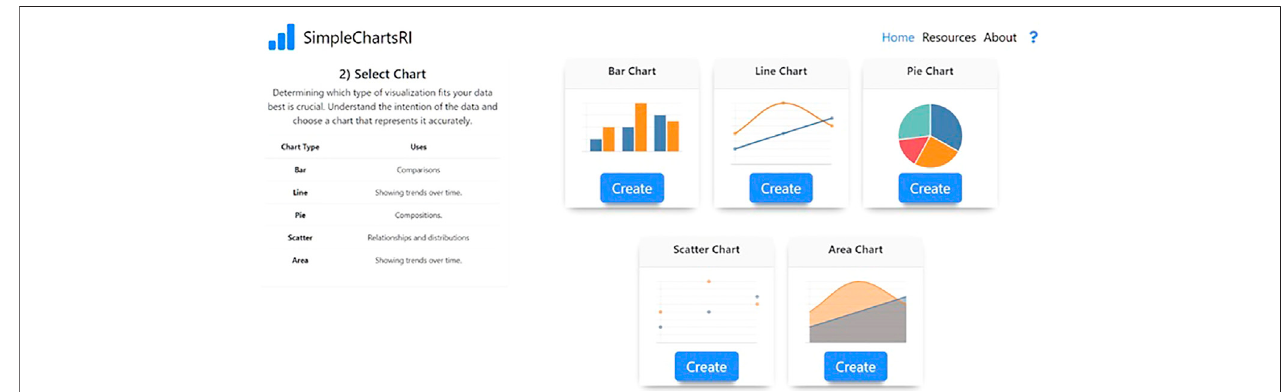
FIGURE 7 | simplechartsri.com chart customization and interaction